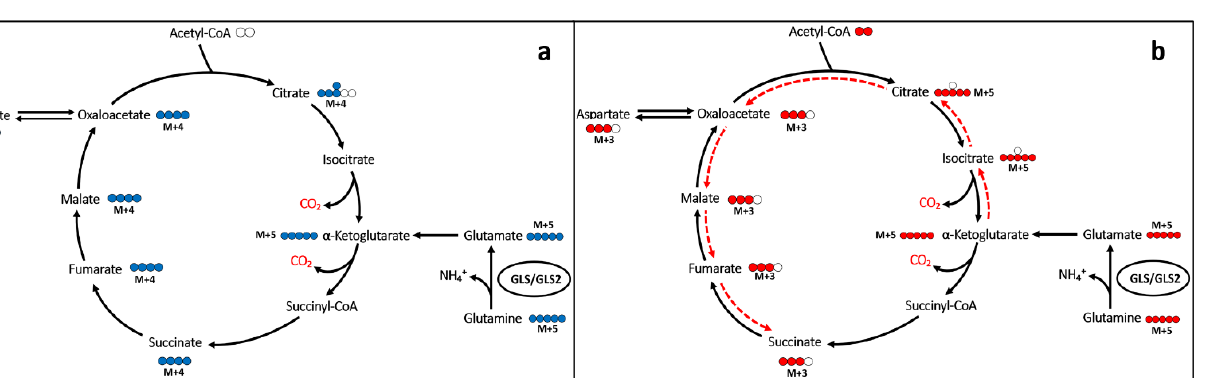
Figure 1. CB-839 inhibits the proliferation of GBM cells in a dose-dependent manner in T98G ( a ), LN229 ( b ) and U87MG ( c ). Dimethyl alpha-ketoglutarate (DMKG) was employed as a metabolic rescue. For each cell line, three independent experiments were made in triplicate. The fold-change in cell number, referring to cells on day 1, is shown.